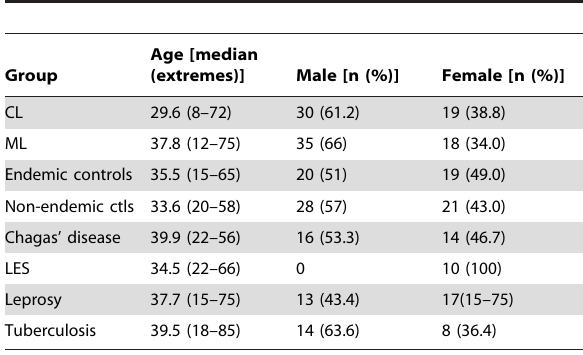
Table 1. Epidemiological characteristics of individuals involved in the